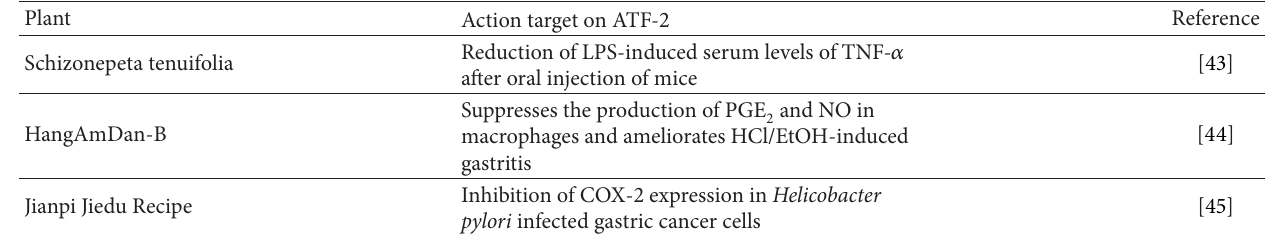
Table 3: Traditional herbs which inhibit the ATF-2 signaling